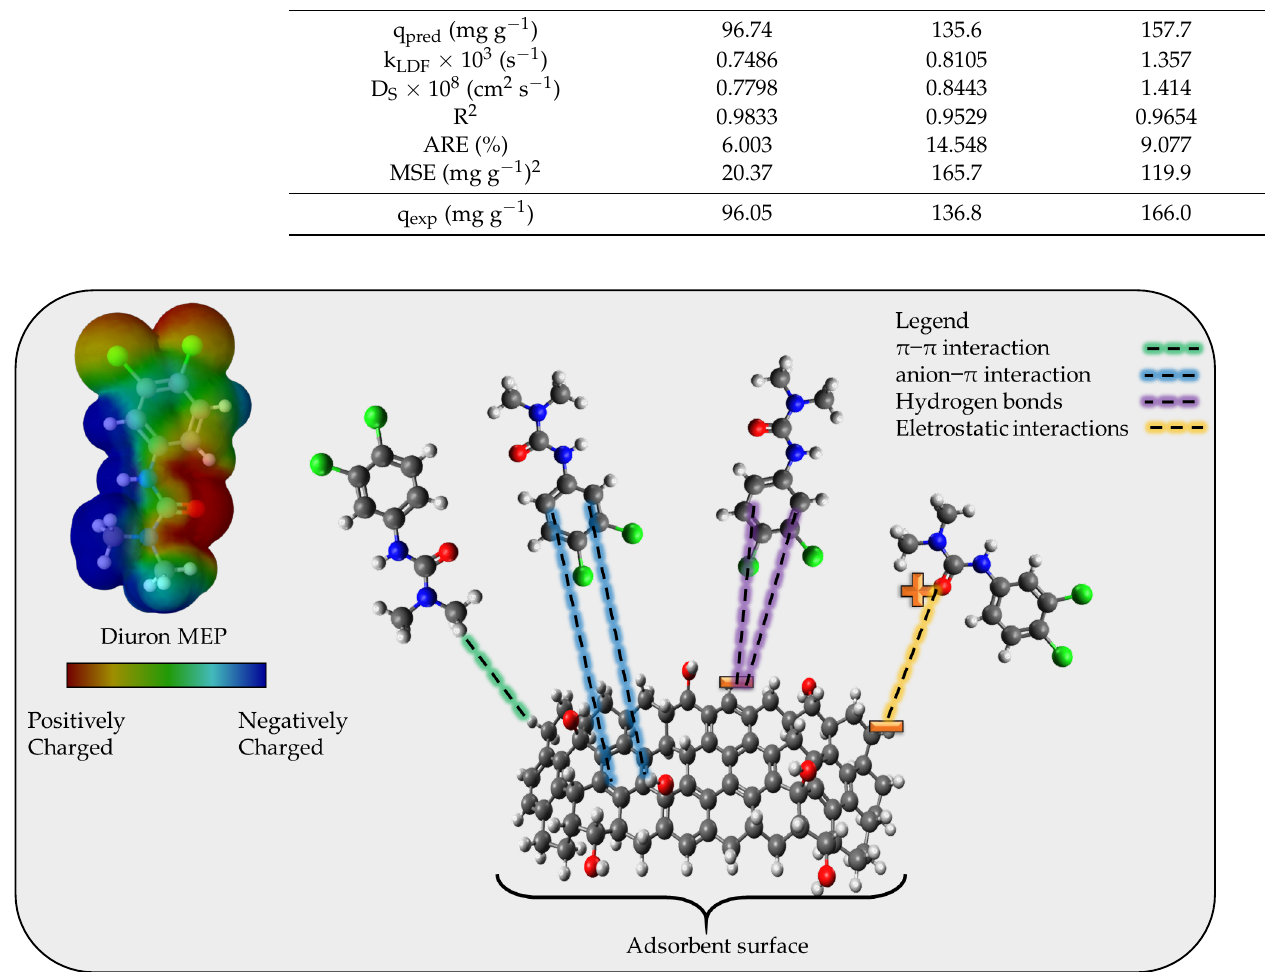
Figure 6. Proposed diuron adsorption mechanism onto the CPAC.